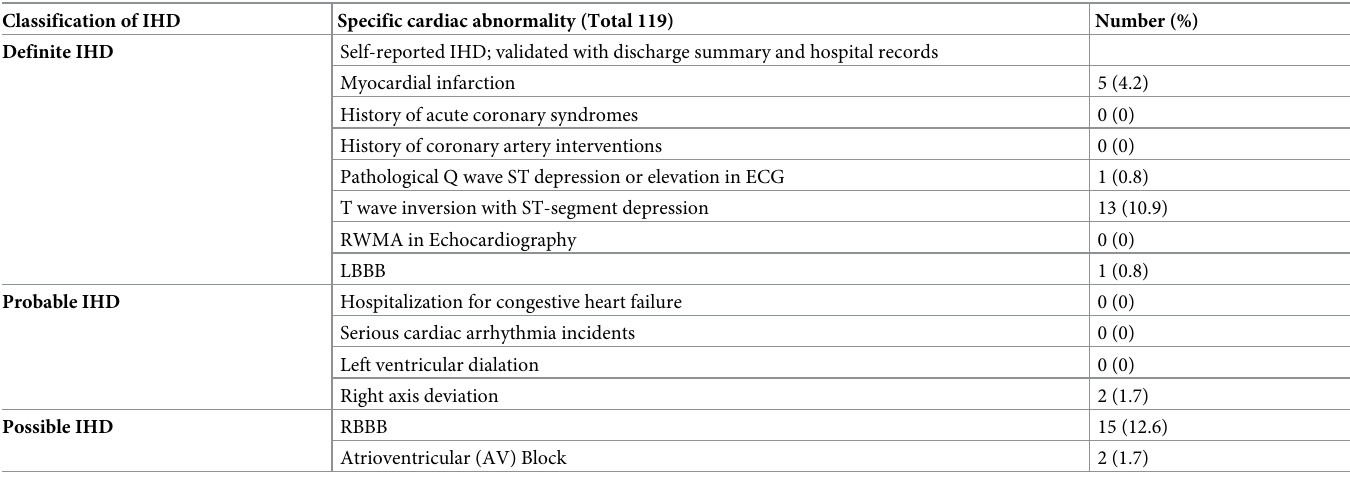
Table 3. IHD manifestations in CKDu Sri